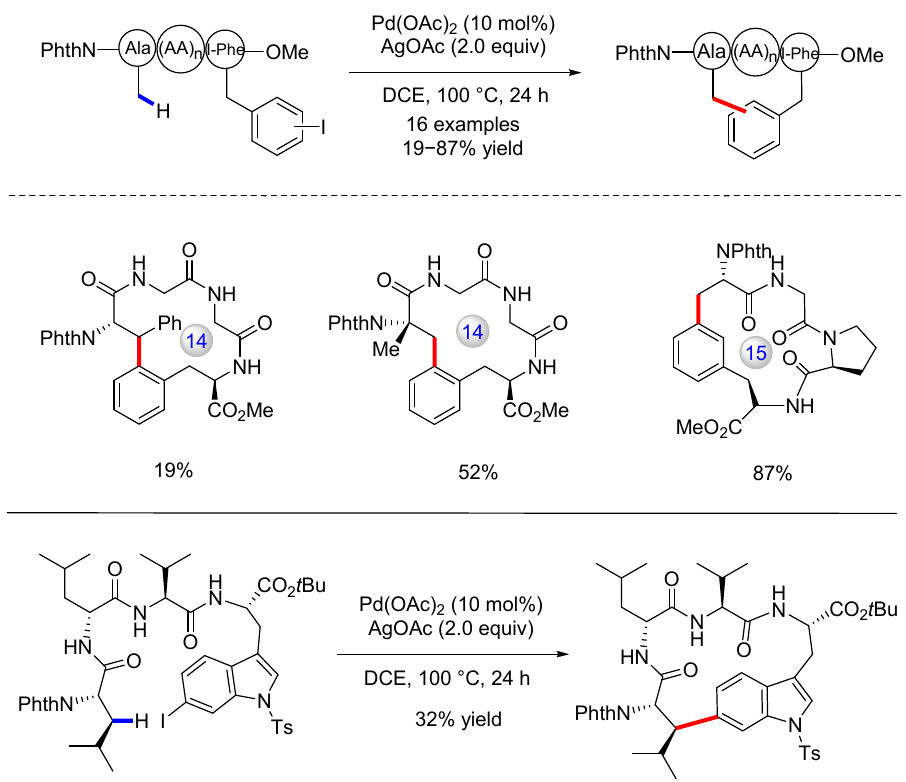
Figure 19. Synthesis of peptide macrocycles via palladium(II)-catalyzed intramolecular C(sp 3 )–H arylation [84].